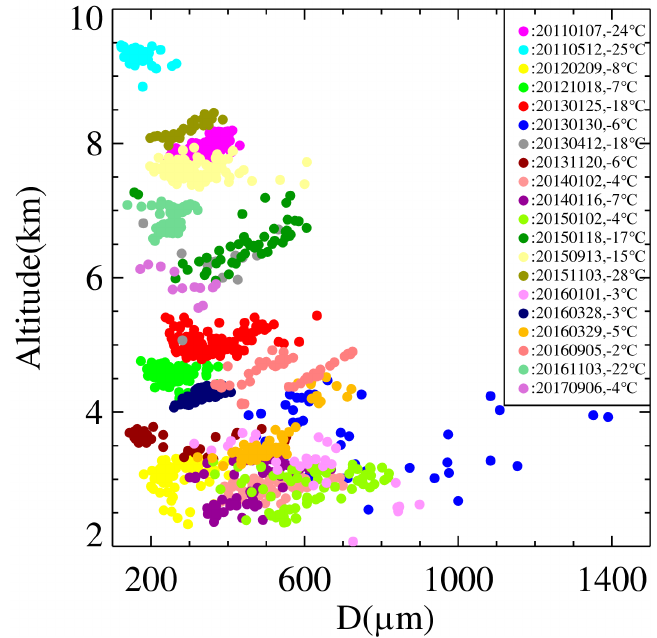
Figure 9. Altitude dependence of the diameters of the ice crystal particles for all the 20 ice virga events observed by our lidar. Each color stands for one event and each circle denotes a diameter over the 1-min profiles. The mean corresponding temperatures of events are also marked in the legend. Only profiles of the strong ice virga (maximum δ > 0.15) were involved in the calculations and statistics. The diameters were obtained by numerically solving the ice particle sublimation equation under the assumption that the final diameters of the ice crystal particles on the ice virga bottom were identical (observation-based value). Note that the ice crystal particles in these virga cases tend to have smaller diameters and narrower size distributions with increasing